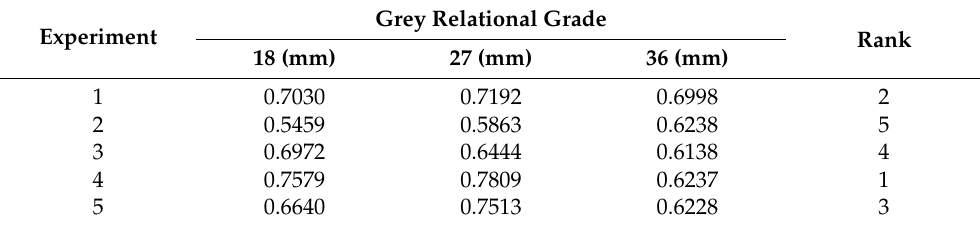
Table 4. GRG for different electrode